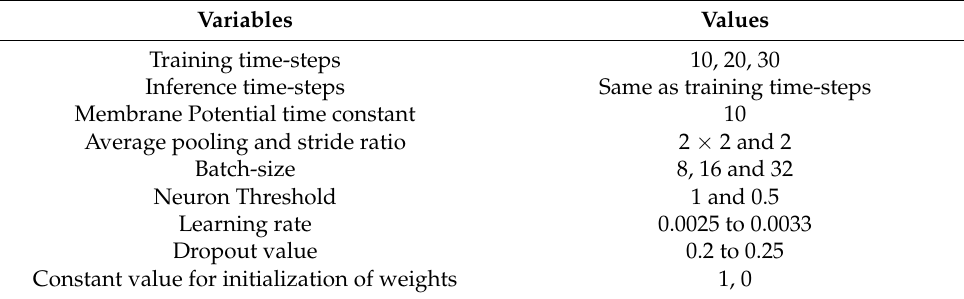
Table 1. Variables used in this research